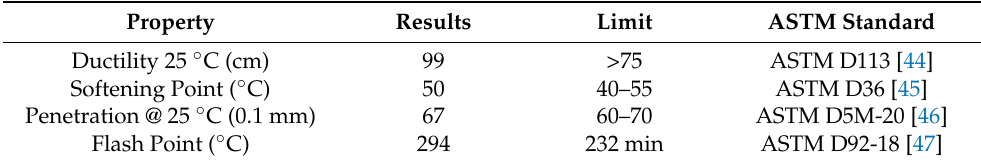
Table 1. Basic properties of binder used for asphalt mix concrete.